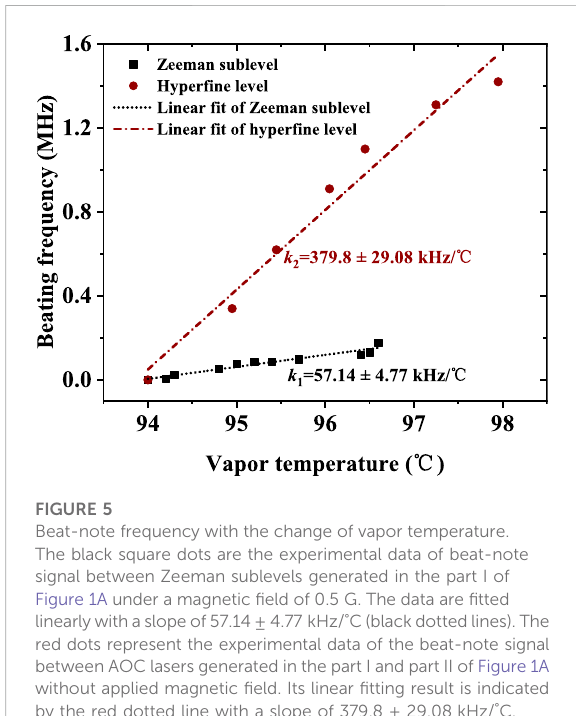
FIGURE 5 Beat-note frequency with the change of vapor temperature. The black square dots are the experimental data of beat-note signal between Zeeman sublevels generated in the part I of Figure 1A under a magnetic fi eld of 0.5 G. The data are fi tted linearlywithaslopeof57.14±4.77 kHz/ ° C(blackdottedlines).The red dots represent the experimental data of the beat-note signal between AOC lasers generated in the part I and part II of Figure 1A without applied magnetic fi eld. Its linear fi tting result is indicated by the red dotted line with a slope of 379.8 ± 29.08 kHz/ °